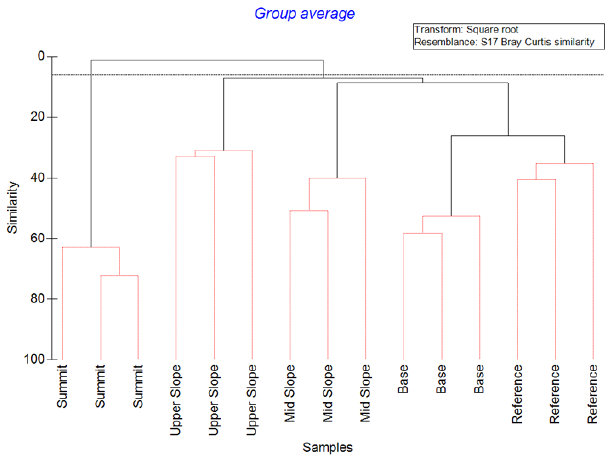
Fig. 4. Hierarchical, group-average linkage Cluster analysis on deployment replicate resemblance for polychaete species along the northern transect of Senghor Seamount. The similarity profile (SIMPROF) test ( p < 0.05) defines non-random clusters in the anal- ysis.